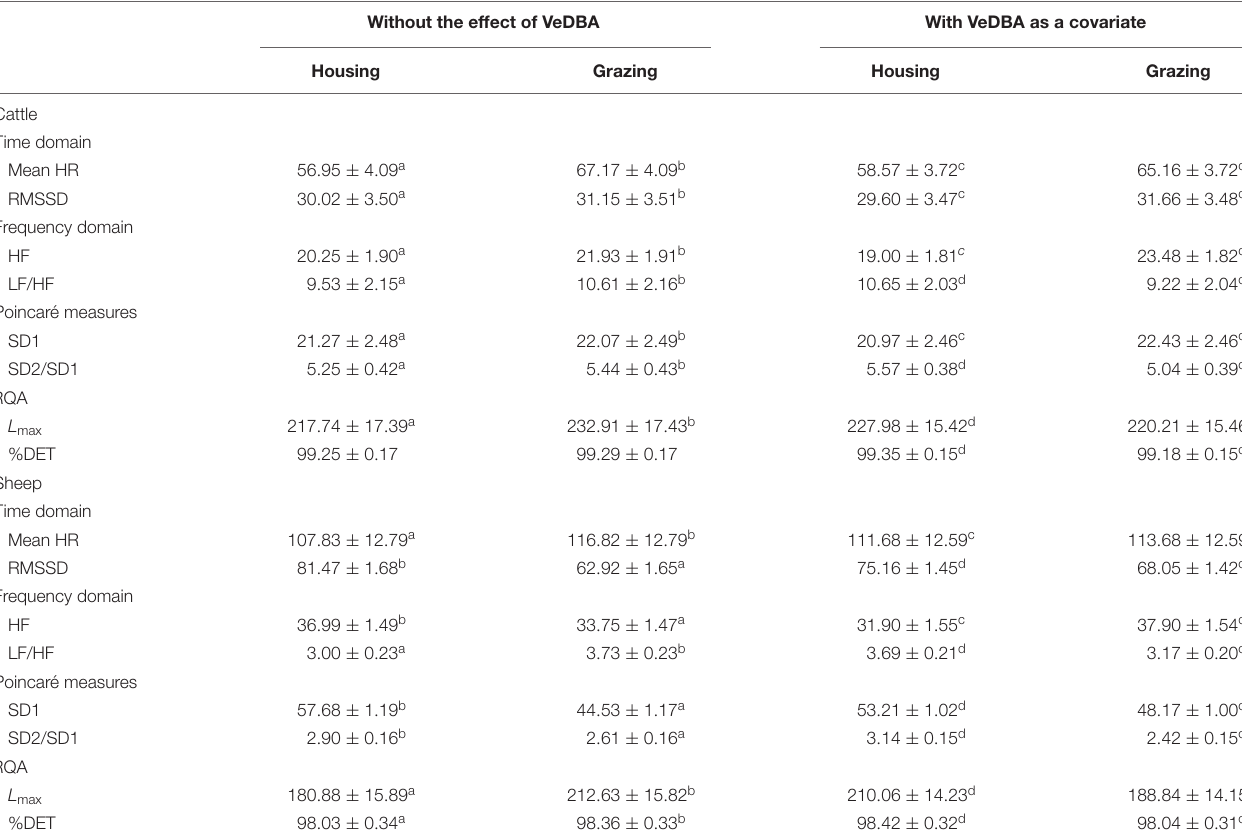
TABLE 4 | The effects of including VeDBA as a covariate on mean HR and HRV parameters in animals under the two management systems. Without the effect of VeDBA With VeDBA as a covariate Housing Grazing Housing